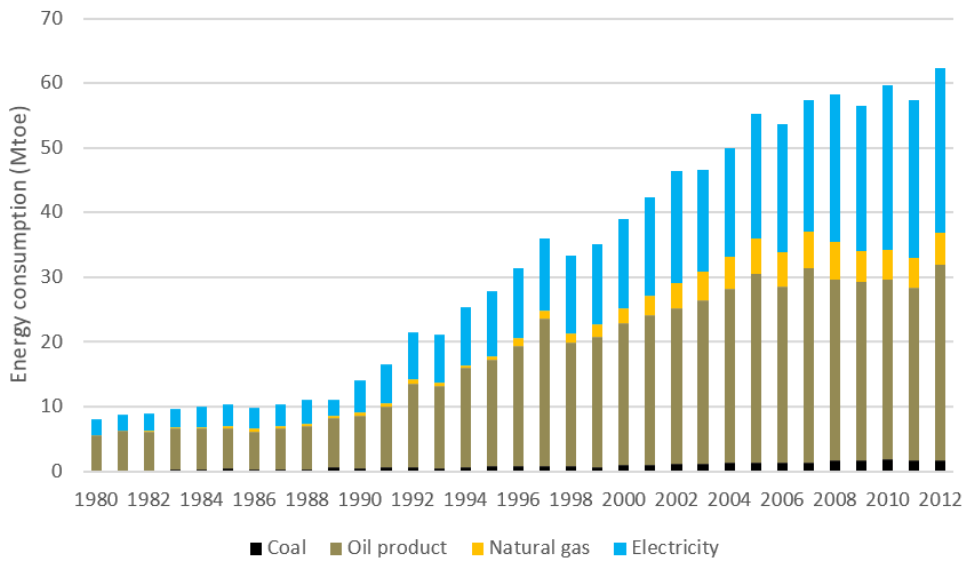
Figure 18. Energy consumption of Malaysia expressed by fuel